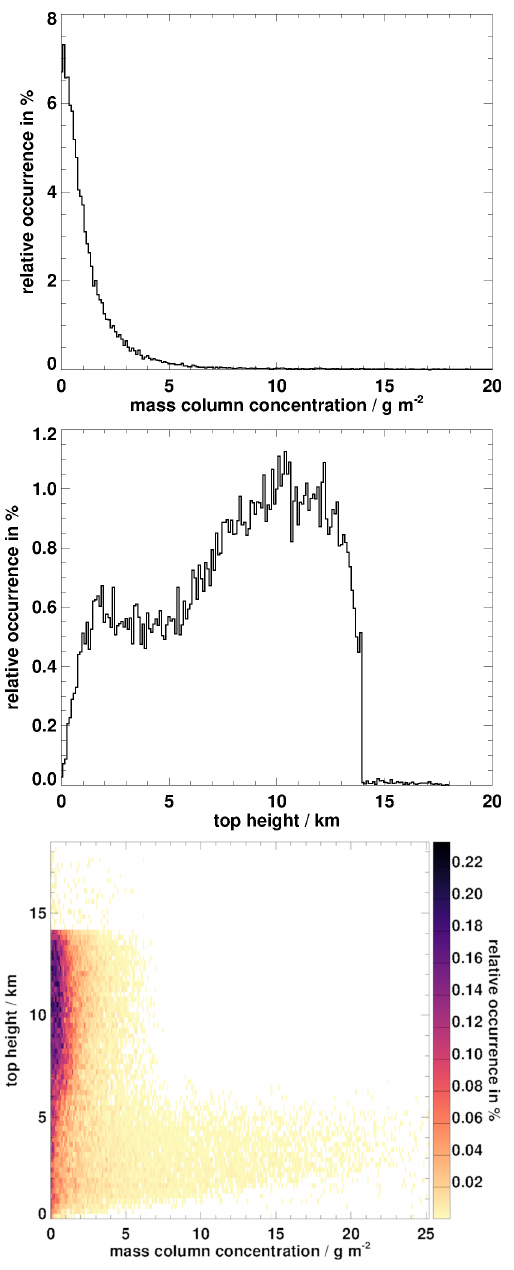
Figure 1. Histogram of ash concentrations and top height in the input data set used for the calculation of the training data set.